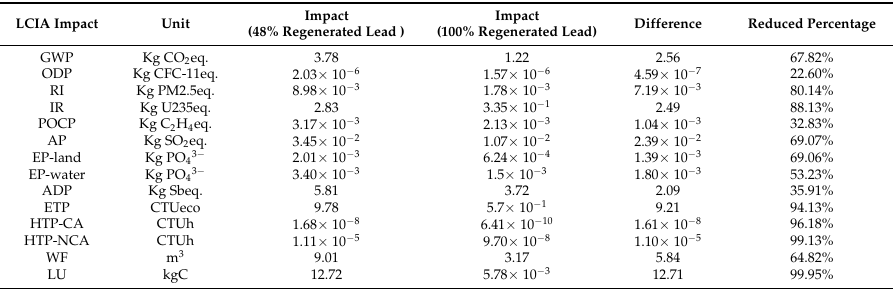
Table 6. The LCIA impacts of LABs in two different